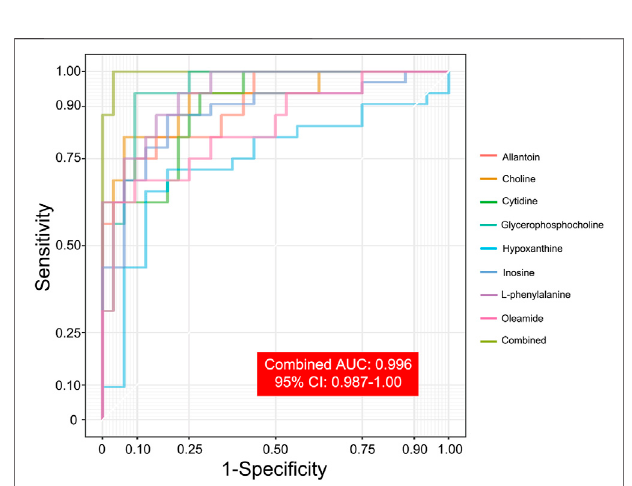
FIGURE 6 | ROC analyses of selected metabolites for predicting EA occurrence. Eight selected metabolites with ROC analyses indicated the potential predictive value of EA occurrence. A combined AUC, marked as grass green, was 0.996 (95% CI: 0.987 – 1.00).